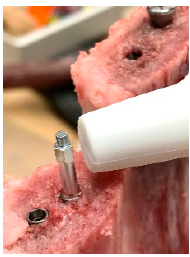
Figure 4. For each protocol implants were placed into the selected bovine ribs with a safe distance to each other by the same clinician. The probe of the Osstell Mentor was held 1 mm from the peg at a 90-degree angle.